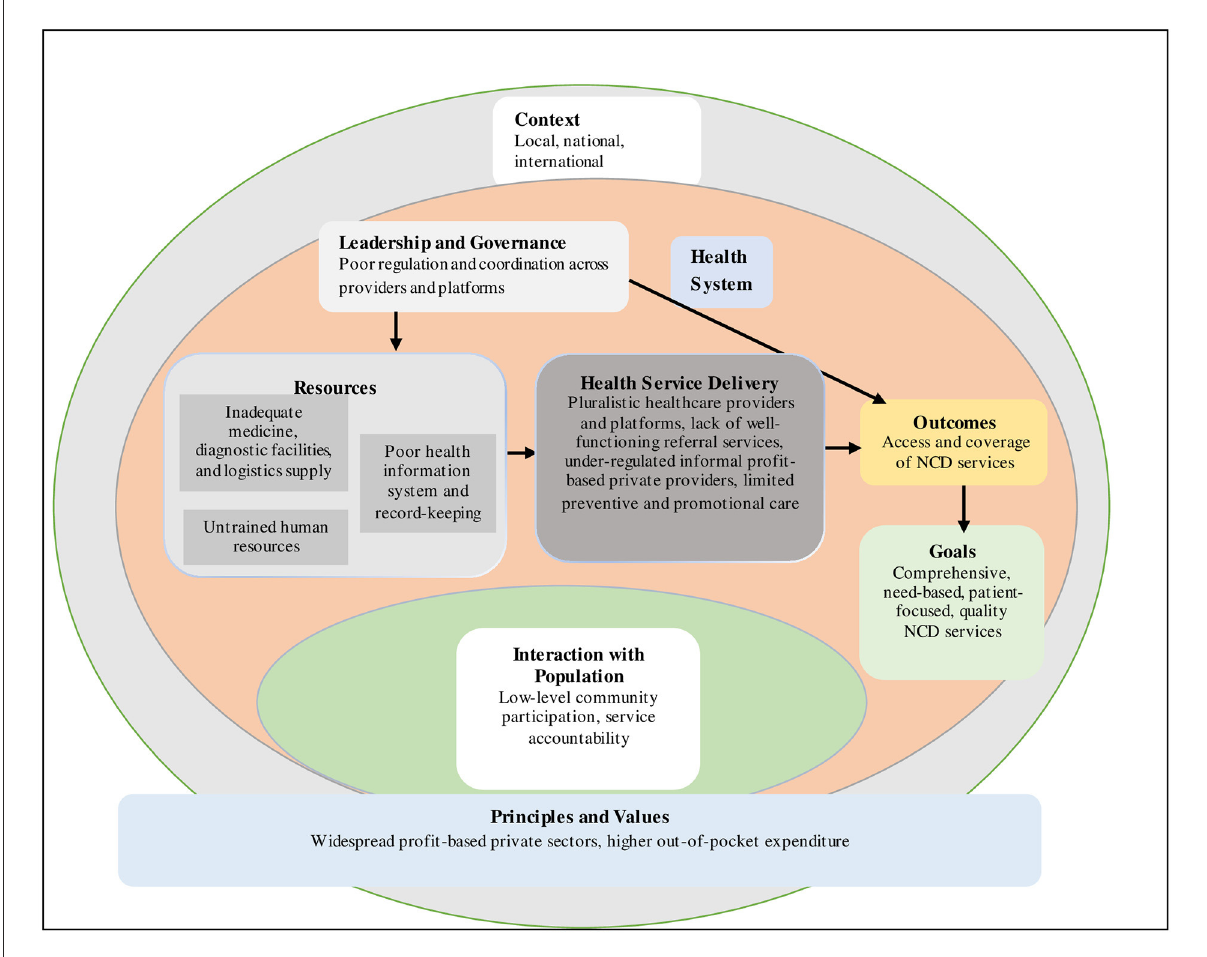
FIGURE1 Health system dynamics framework on health system challenges to organize NCD services at the PHC